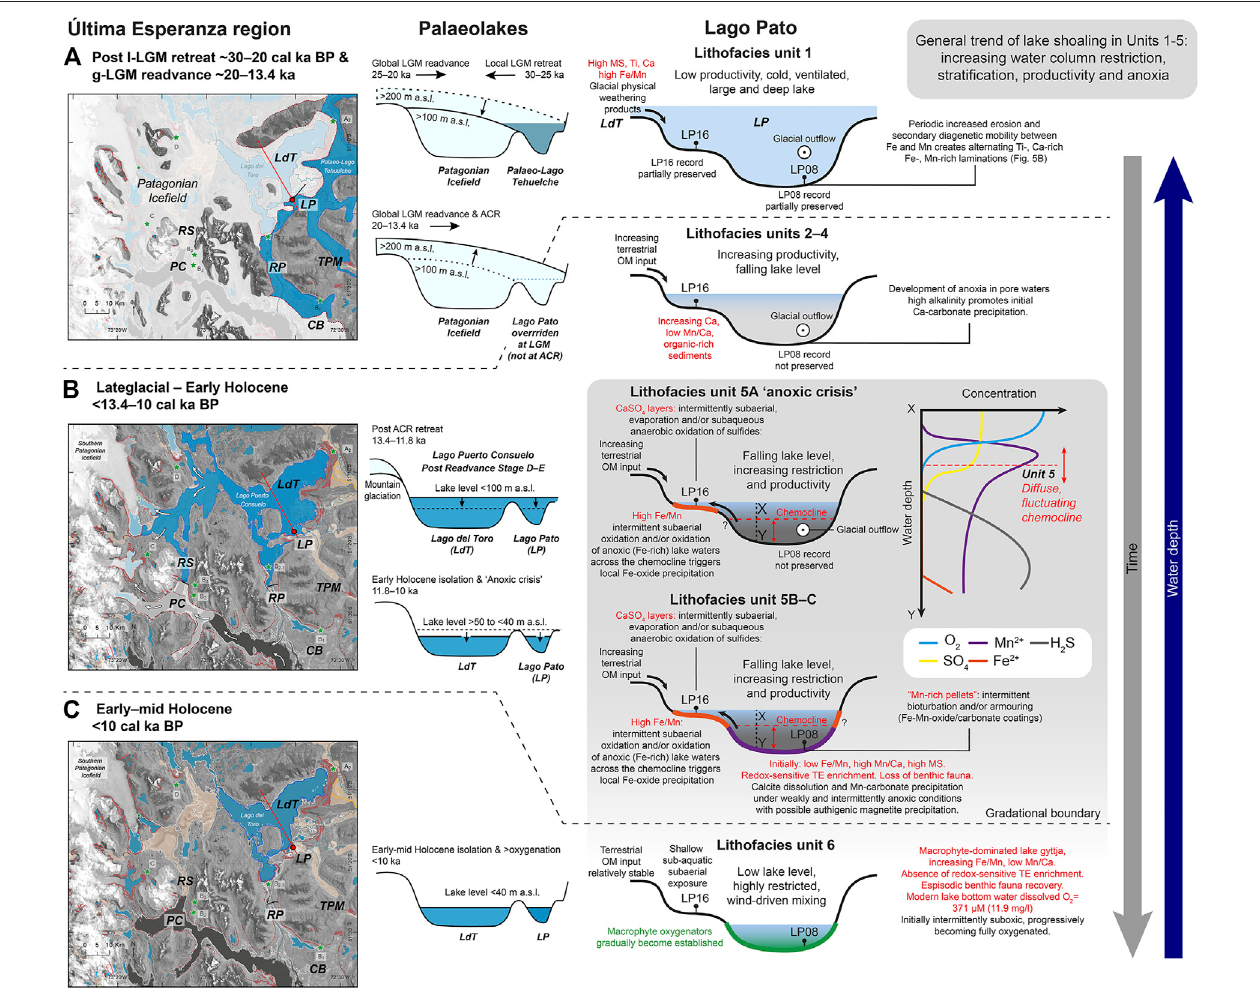
FIGURE 9 | Schematic cartoon and lake ontogeny model illustrating changes in glacial activity and its impact on the Lago del Toro lake level and development of Lago Pato and in the last ~30 ka. (A) Cross section across Lago del Toro (LdT) and Lago Pato (LP) during the retreat from local-LGM (l-LGM) glacial limits and during readvance to global-LGM (g-LGM) limit. The outline of Palaeo-Lago Tehuelche (blue) formed after the l-LGM and the extent of the Southern Patagonia Ice fi eld are adaptedfromGarciaetal.(2014).PCisPuertoConsuelo,TPMisTresPasoMoraine,CBisCerroBenetiz,andRSisRioSerrano. (B) Palaeo-LagoPuertoConsuelo at c. 13.4 – 11.7 ka after the fi rst major lake lowering event and during the early Holocene isolation of Lago del Toro and Lago Pato, between c. 11.7 and 10 ka. Isolation occurred when the palaeolake level fell below ~40 m a.s.l. after glaciers retreated from the Puerto Consuelo area, removing the ice-dam at ~50 m a.s.l. that retained the enlarged palaeolake over Lago del Toro and Lago Pato.Glacier limits shown in (B) are minima at c. 11.3 ka following the retreat from advanced ACR positions along the RíoSerrano(RS)and from theCerro Benetiz (CB) area(adaptedfrom García et al.(2014) and thereferencestherein). (C) Development ofLagoPato asanisolatedbasin < 10 ka. Chemocline changes in the lithofacies model are based on the Brownie Lake pro fi les (Wittkop et al., 2020), with observations in black text and interpretations in red text. This fi gure was made in ARC-GIS and Adobe Illustrator.